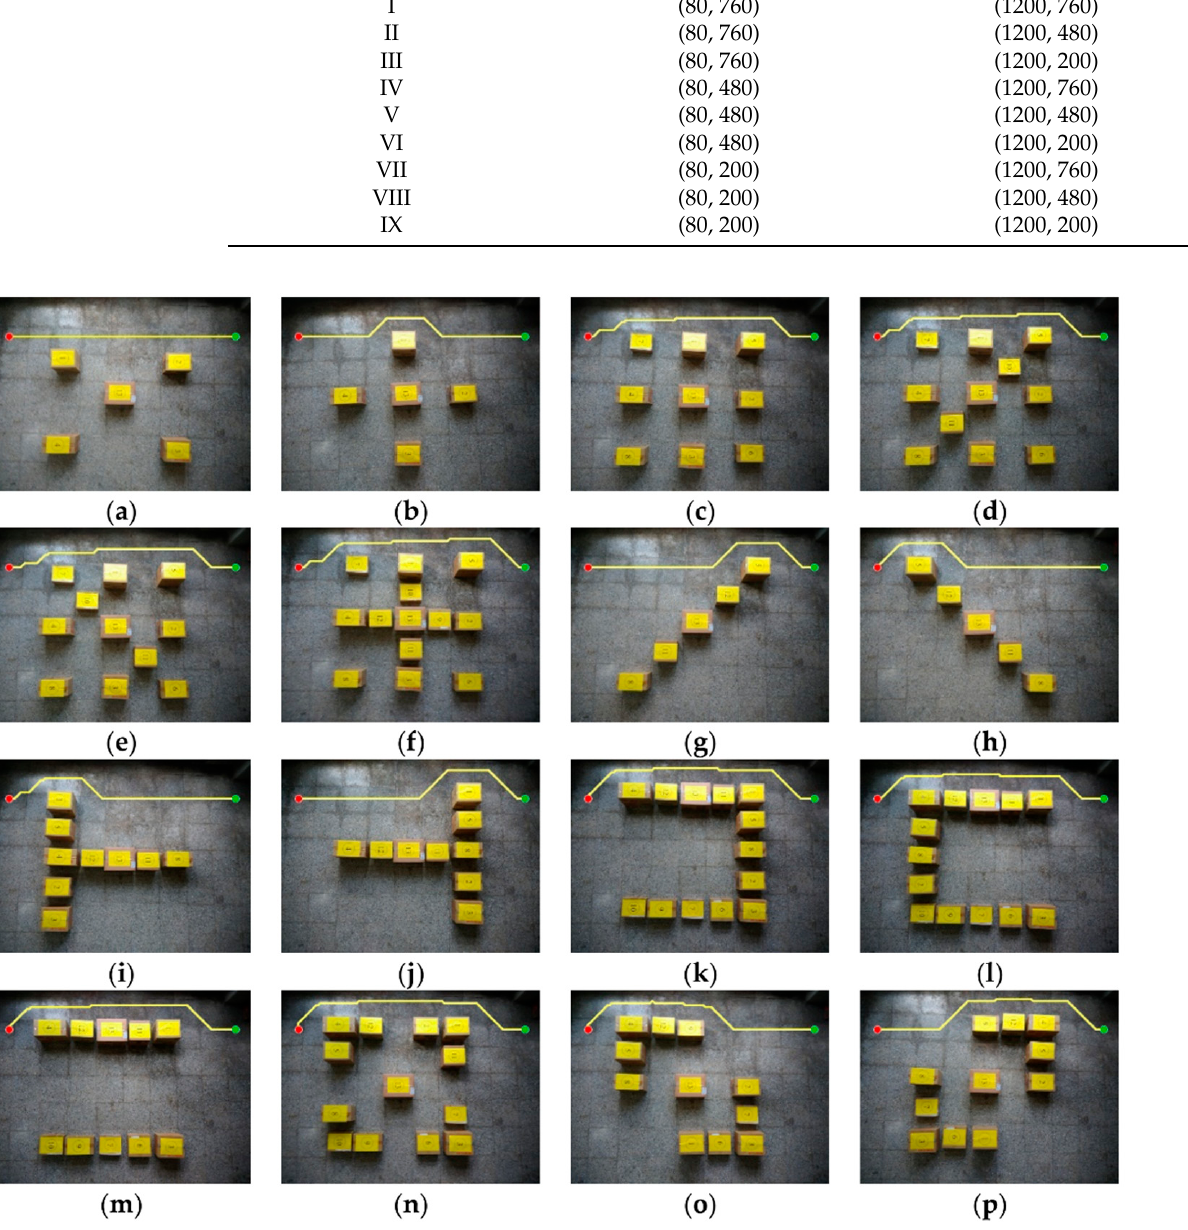
Figure 20. Planned paths shown in Experiment I: ( a ) result #1; ( b ) result #2; ( c ) result #3; ( d ) result #4; ( e ) result #5; ( f ) result #6; ( g ) result #7; ( h ) result #8; ( i ) result #9; ( j ) result #10; ( k ) result #11; ( l ) result #12; ( m ) result #13; ( n ) result #14; ( o ) result #15; ( p ) result #16.